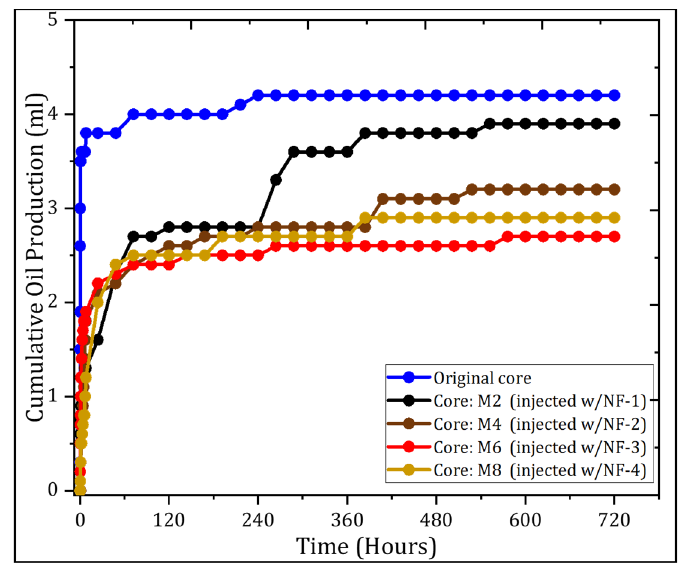
Figure 7. Oil recovery by spontaneous imbibition versus time.